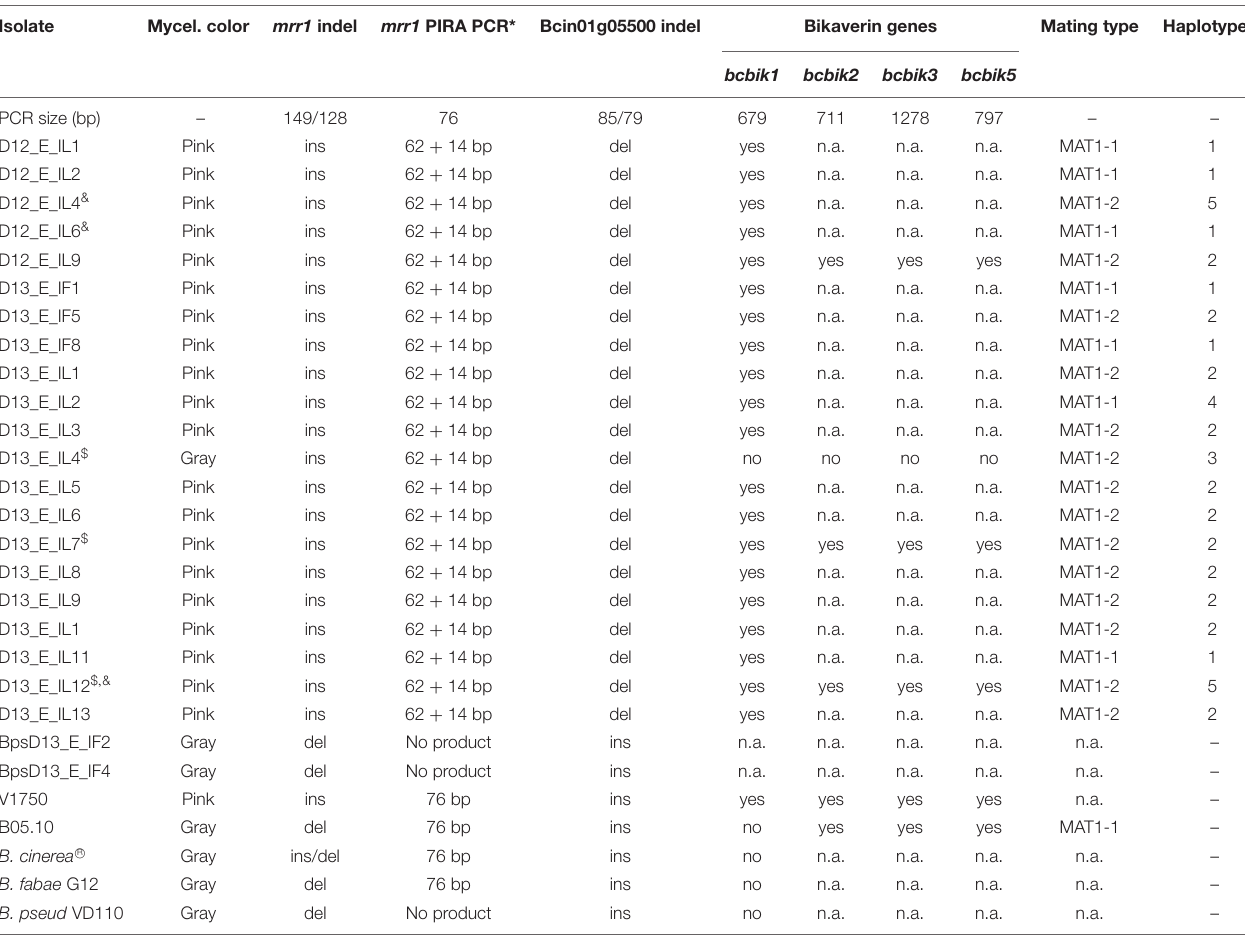
TABLE 3 | Genetic and phenotypic differentiation of B. cinerea Iris strains. Isolate